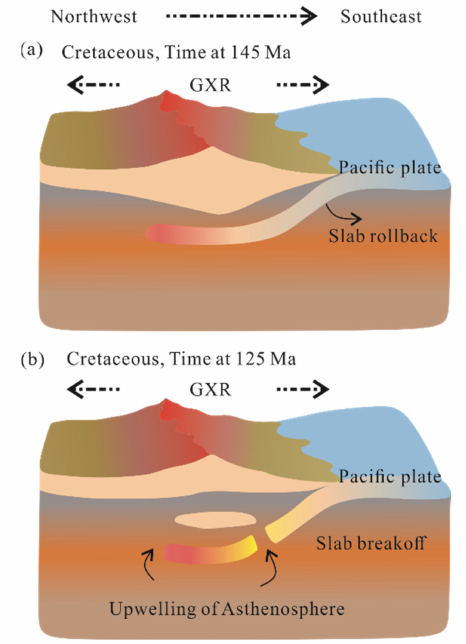
Figure 4. Sketch diagram of possible mechanisms corresponding to the transitions at 125 and 145 Ma in the GXR. The anomalies in age transition identified are linked to plate subduction or collision caused by short spurts of mantle convection during the formation of supercontinents and continent crust growth [13,18,26]. The transition at 145 Ma may be related to slab rollback due to the subduction of the Pacific Plate, while the transition at 125 Ma may be related to slab breako ff of the Pacific Plate, coupled with the upwelling of asthenosphere, the delamination of thickened crust, and magmatic eruptions. Great Xing’an Range, GXR, Northeast China, East